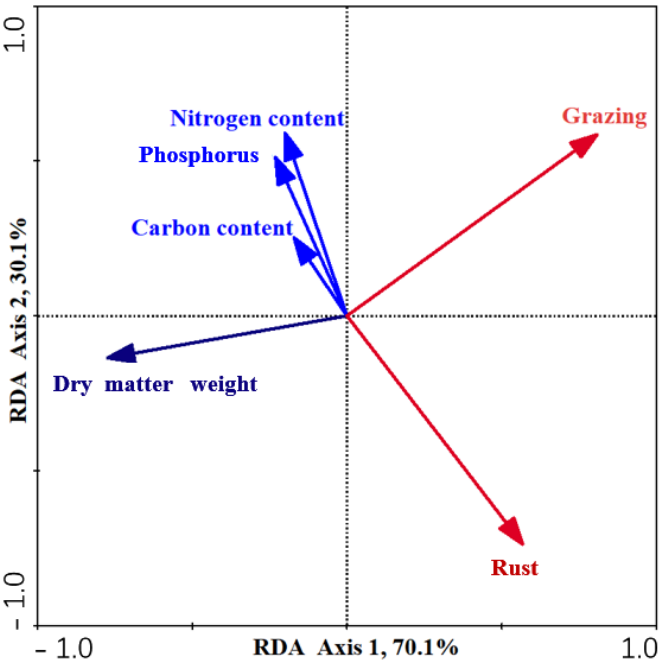
Figure 7. Redundancy analysis (RDA) of the effects of grazing and rust on dry matter, carbon, nitrogen, and phosphorus contents (%) of Leymus chinensis , showing the correlational relationships among grazing intensities (0, 0.42, 0.63, 0.83, 1.25, and 1.67 cattle ha − 1 ), disease (rust), dry matter of L . chinensis, and the content of elements (C, N, and P). Direction of arrow indicates the correlation between the parameters, and the length of the arrow indicates the magnitude of the association.